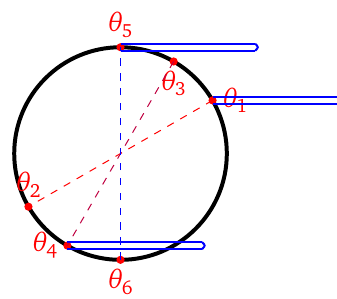
Figure 6: The 3-fold Schwinger-Keldysh contour characterising six-point